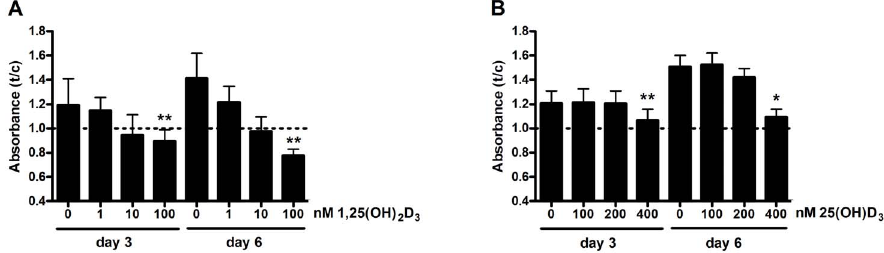
Figure 1. Effects of 1,25(OH) 2 D 3 and 25(OH)D 3 on primary human osteoblast proliferation. Osteoblasts were cultured in the presence of 0, 1, 10 or 100 nM 1,25(OH) 2 D 3 ( A ) and 0, 100, 200 or 400 nM 25(OH)D 3 ( B ) and the proliferation was quantified at day 3 and 6. Results (mean 6 SEM) are expressed as treatment versus control ratios (time-point 0 was set at 1.0) using cells from 4 (A) or 7 (B) different donors. Results were analysed using Friedman test followed by Dunn’s post hoc test for each timepoint (*p , 0.05, **p , 0.01, ***p , 0.001).